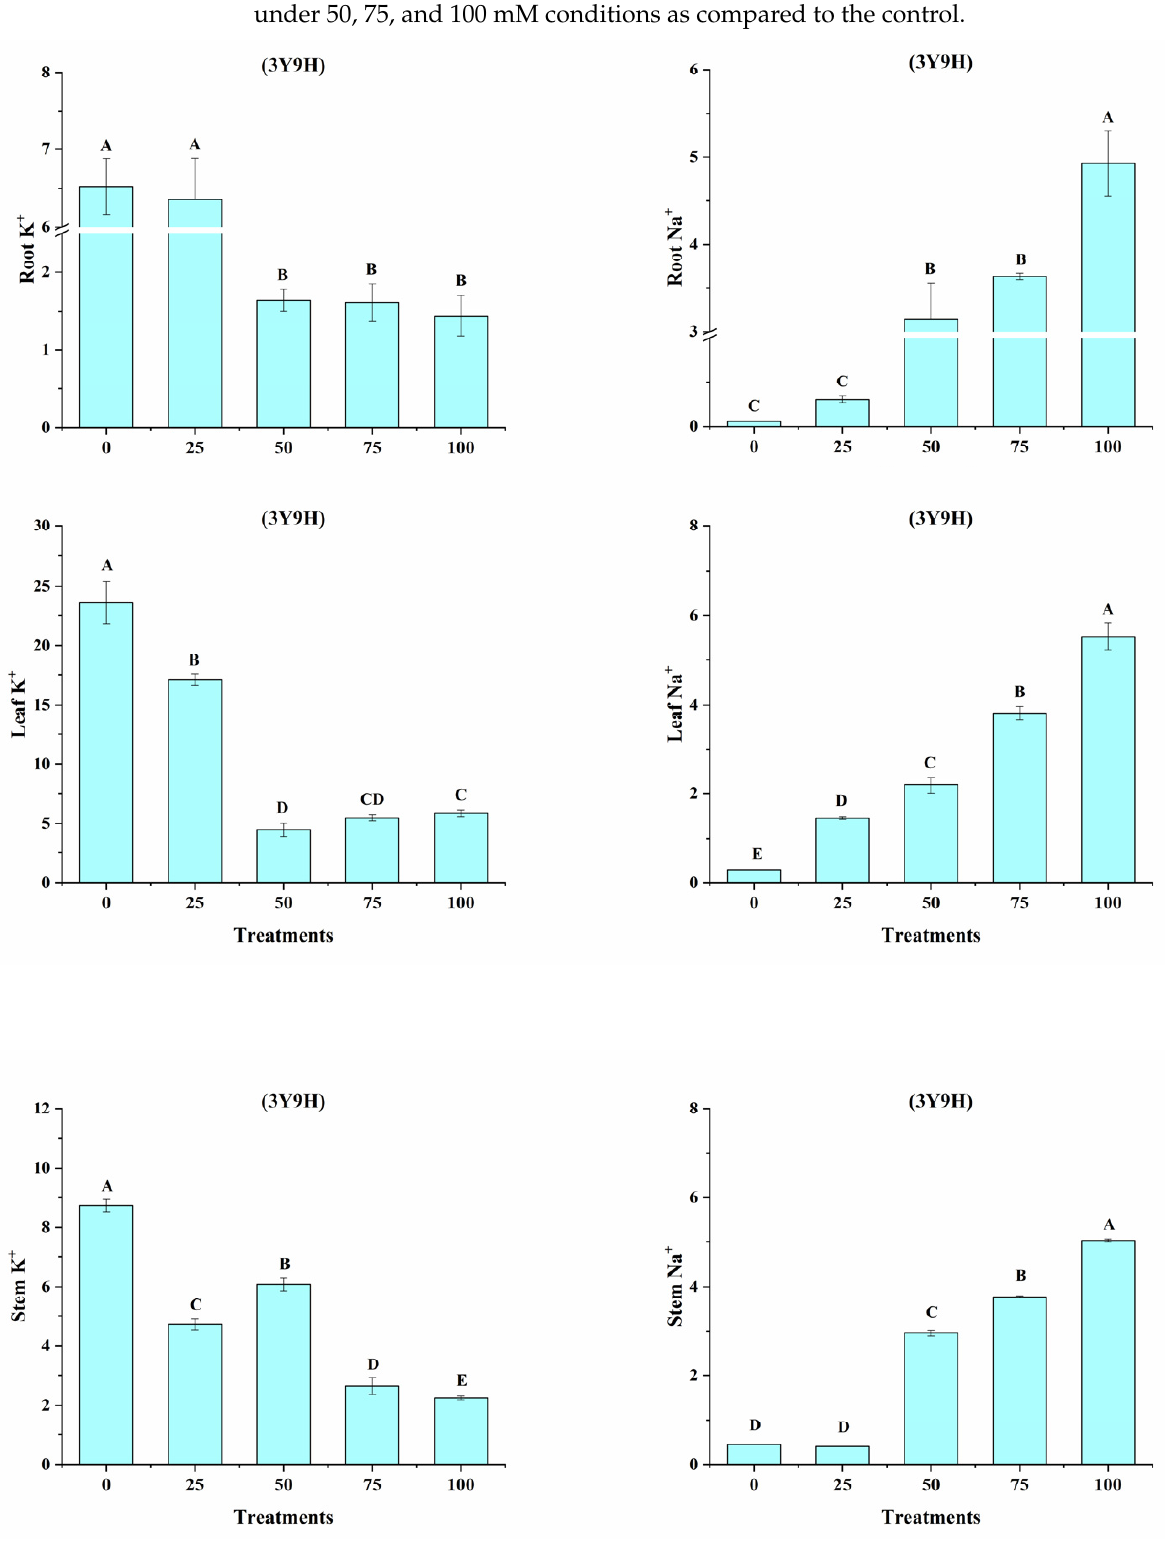
Figure 12. Na + , K + , and ratio in tolerant cultivar (3Y9H) and five salt concentration treatments (0, 25, 50, 75, and 100 mM). Different letters showed the significant variance at p < 0.05.